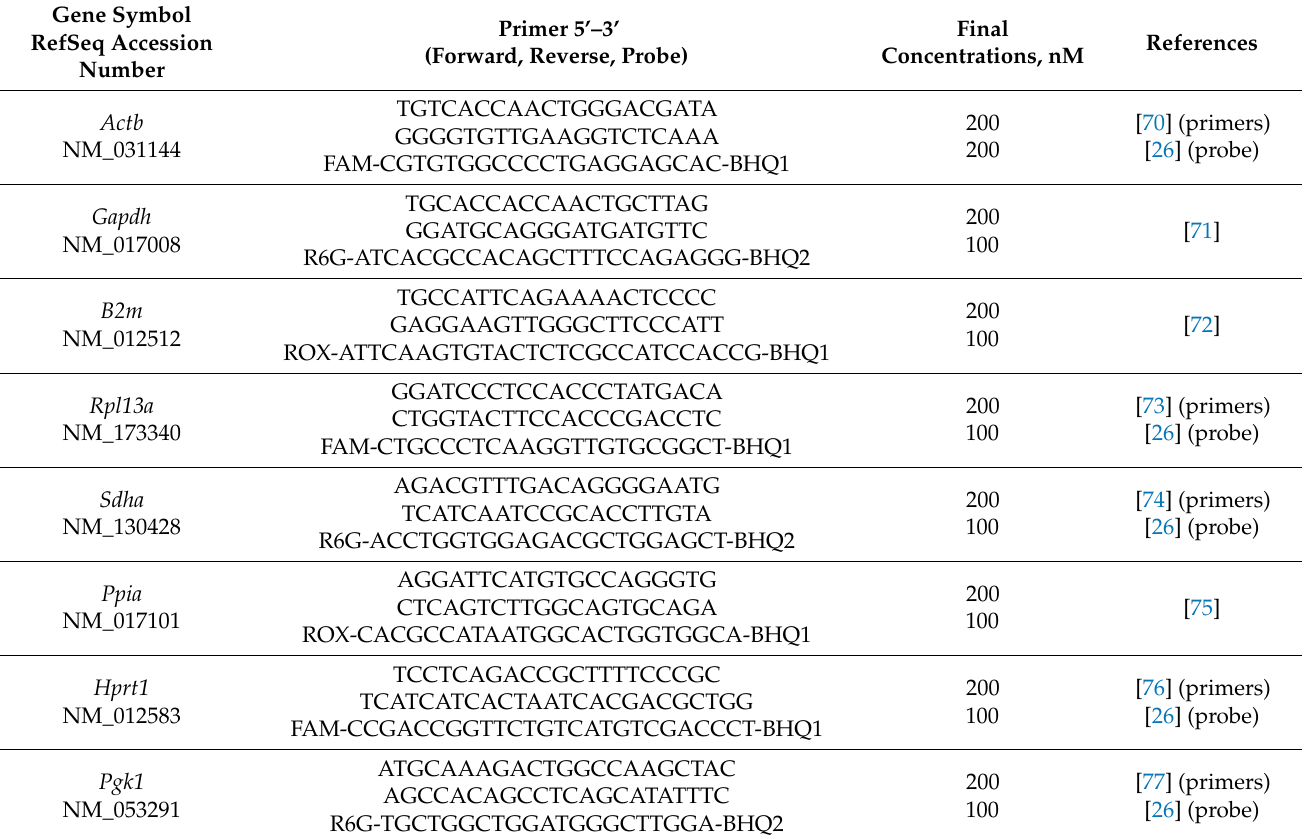
Table A1. Primers and probes (DNA Synthesis Ltd., Moscow, Russia) used for RT-qPCR. Gene Symbol RefSeq Accession